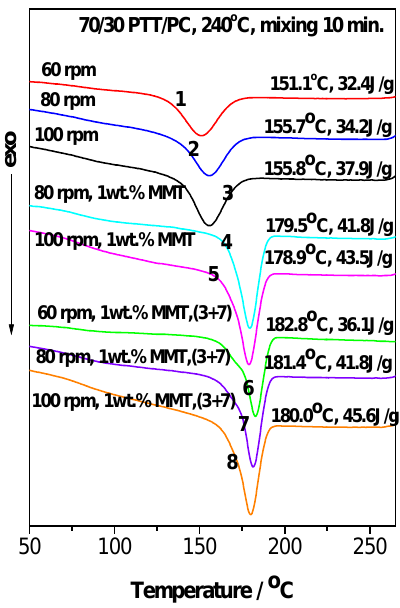
Figure 2. Influence of the shear rate, MMT (Cloisite ® 25A) and processing mode on the crystallization of the 70/30 PTT/PC blend processed at 240 °C for 10 min. (3 + 7) signifies that PTT was mixed with MMT for 3 min and then added to the PC and mixed continuously for 7 min.